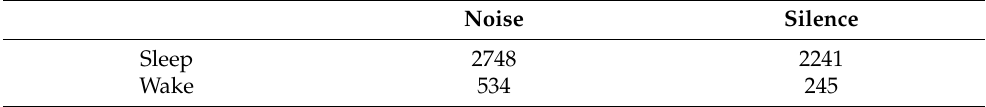
Table 3. Number of 15-s actigraphy epochs classified as sleep or wake in the presence of noise or silence (first 90